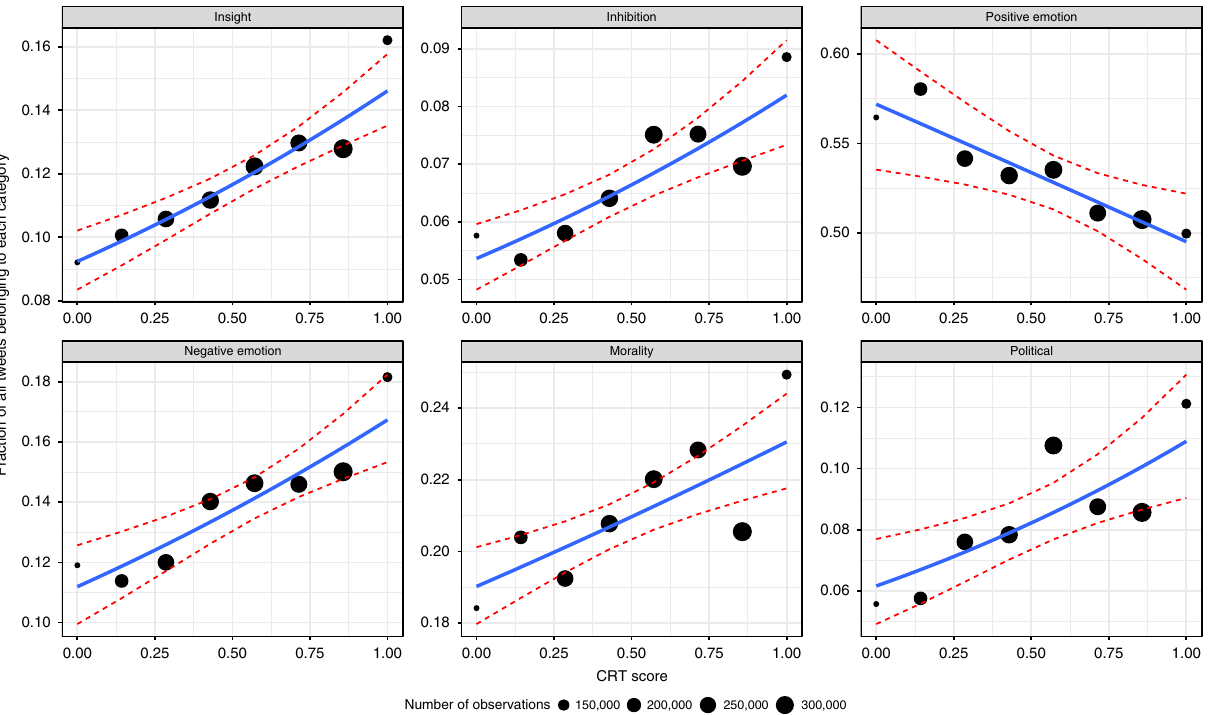
Fig. 4 Word categories versus CRT score. For each word category and CRT score, dots represent the fraction of all tweets that have at least one word from that category. The size of the dots shows the number of tweets. Lines represent the relationship between word categories and CRT score using weighted least-square estimation. Red lines show 95% con fi dence internal based on the logistic regression model fi tted on individual observations. Only the relationships between CRT score and “ Insight, ” “ Inhibition, ” “ Negative emotion, ” “ Morality, ” and “ Political ” are signi fi cant when controlling for